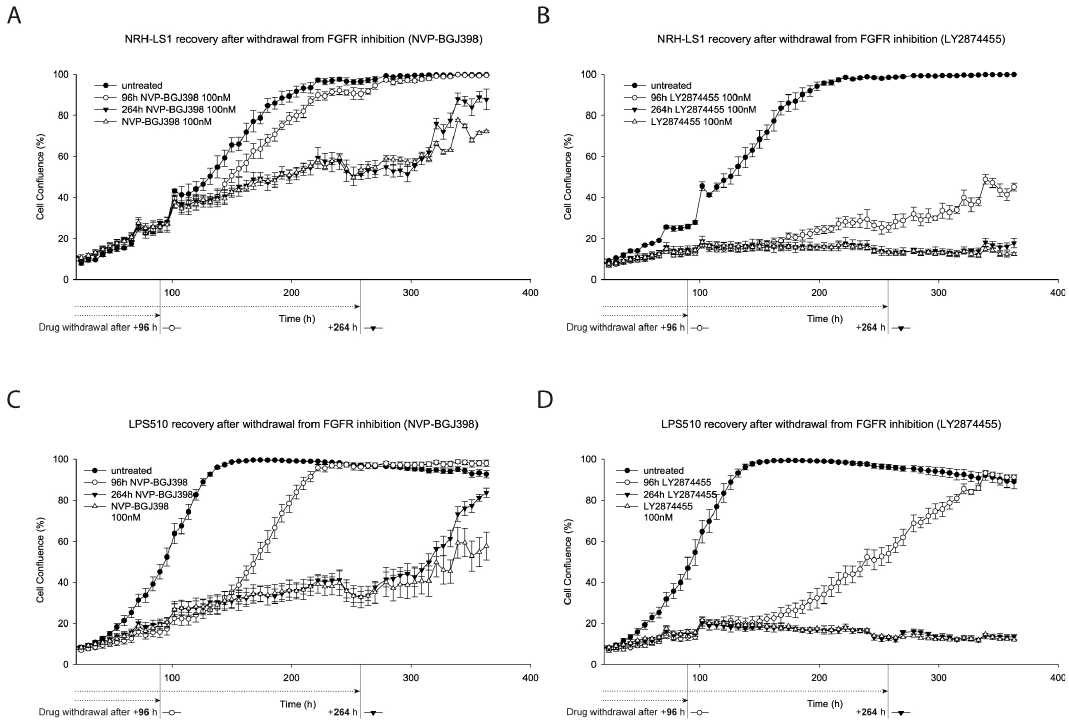
Figure 3. NRH-LS1 and LPS510 cells resume proliferation after withdrawal of treatment with NVP-BGJ398, but not LY2874455. Proliferation of NRH-LS1 ( A , B ) or LPS510 ( C , D ) cells treated with 100 nM of NVP-BGJ398 ( A , C ) or LY2874455 ( B , D ) continuously or upon withdrawal of the drug after 96 h or 264 h of treatment. One representative experiment is shown ( n = 3), error bars represent the standard error of the mean (SEM) of technical replicates. For all experiments untreated with DMSO concentration corresponding to that of the highest drug